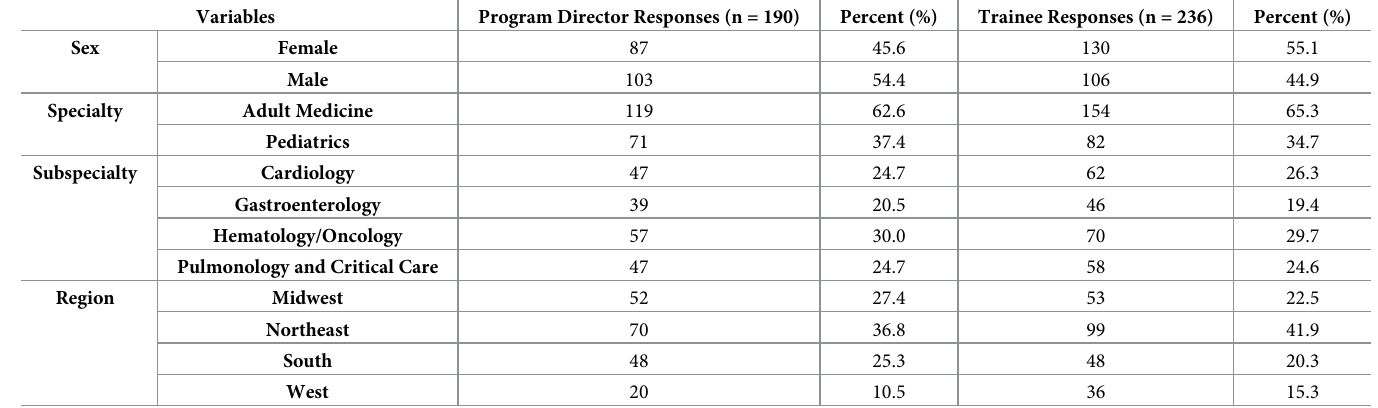
Table 1. Baseline characteristics.